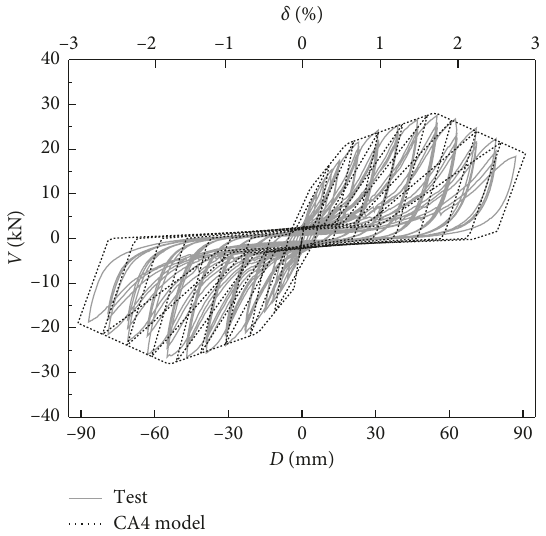
Figure 7: Comparison of test V-D response with fitted CA4